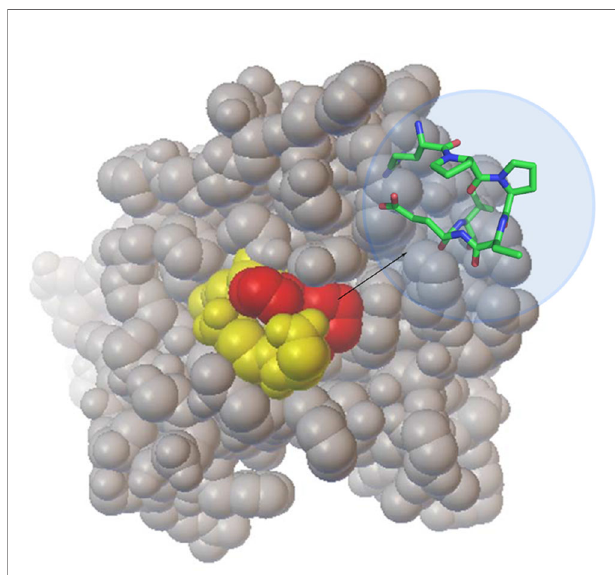
FIGURE 4 | LocationoftheRPPDEImotifinCTA1. Aspace- fi llingmodeloffolded, holotoxin-associatedCTA1 (PDB entry1S5E) highlightsthe PPresiduesinredand theRDEIresiduesinyellow.Theinsetstickstructureprovidesa moredetailedview ofthe trans conformationspresentatthePPresidues